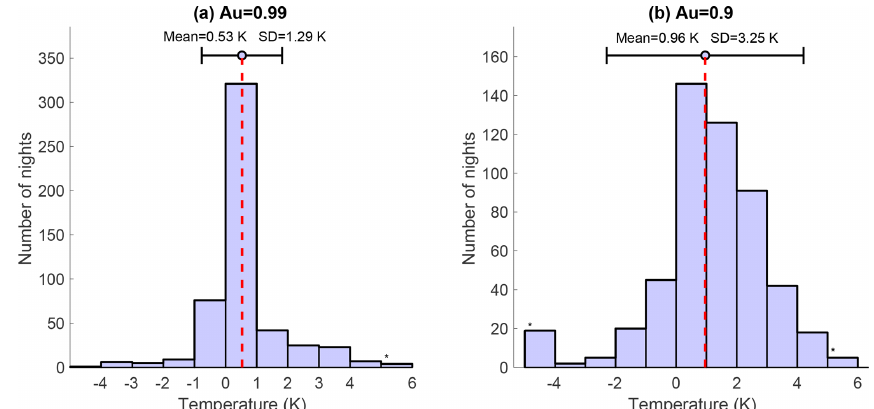
Figure 1. Distribution of the differences in temperatures retrieved at the altitudes where the sum of the averaging kernels ( A u ) is 0.99 (a) and 0.9 (b) using two a priori temperature profiles – the US Standard Atmosphere and CIRA-86 – for over 500 nights as de- tailed in Jalali et al. (2018). The red dashed line shows the mean. For each case, the difference in temperatures is always smaller than the statistical uncertainty at the same